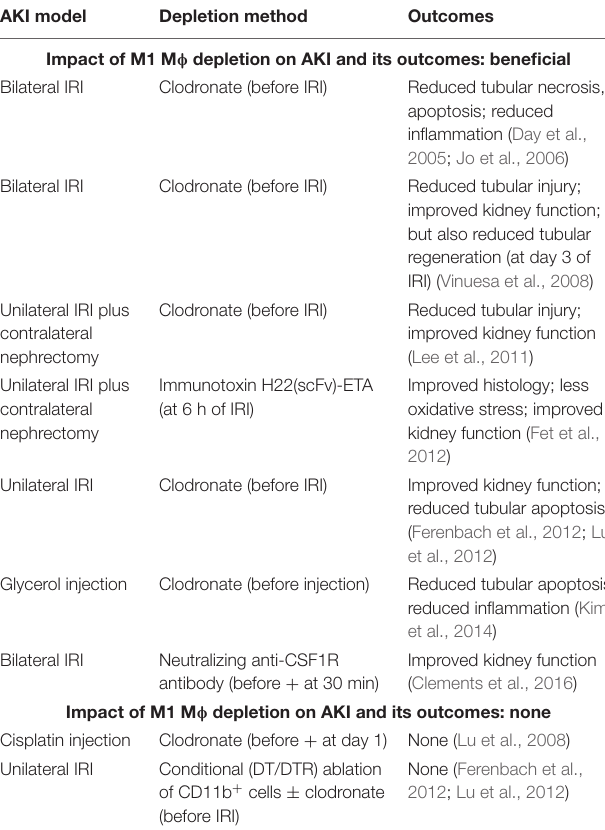
TABLE 2 | Impact of M1 M φ depletion on AKI and its